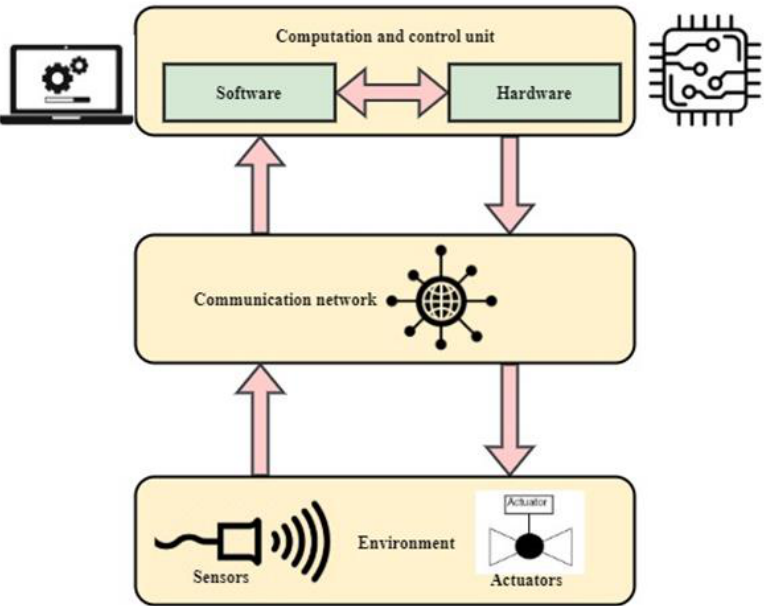
Figure 5. The data processing module of the proposed IWMCPS model.